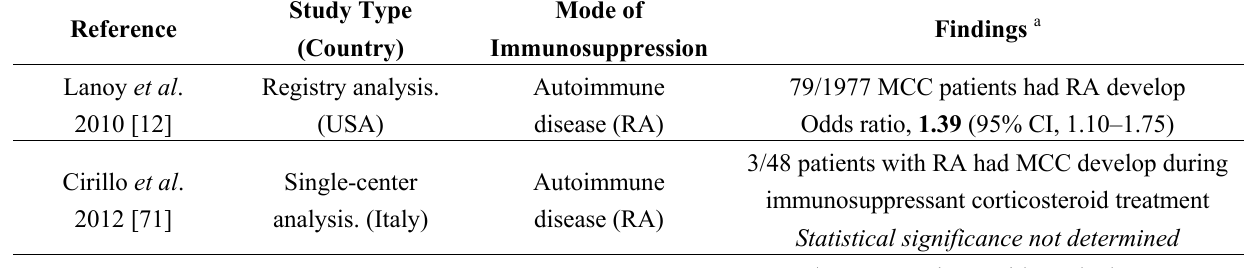
Table 4. Summary of relative risks of MCC occurring after various forms of